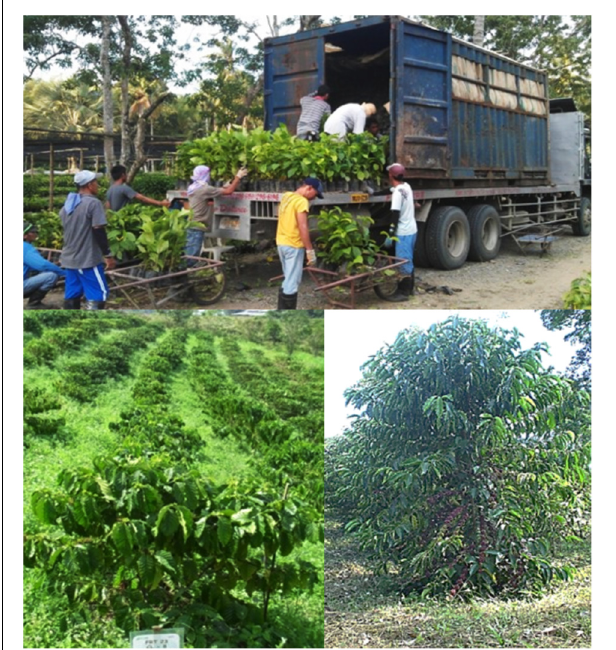
FIGURE 9 | Robusta SE plants produced in Nestlé’s French facility and distributed to farmers in the Philippines (Top) ; young trees in the field (Mindanao Island, Bottom Left ); locally produced SE tree bearing fruits in a Mexican plantation (Chiapas, Bottom Right